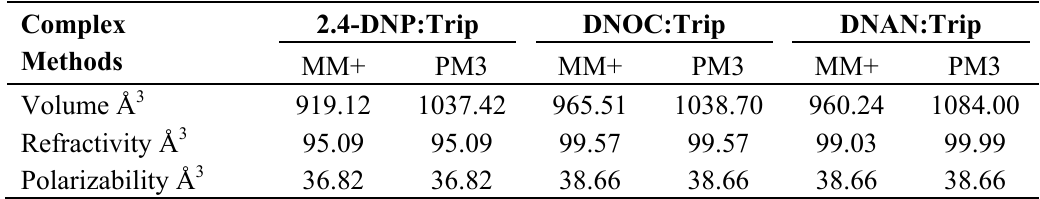
Table 4. QSAR properties of complexes calculated by MM+ and PM3